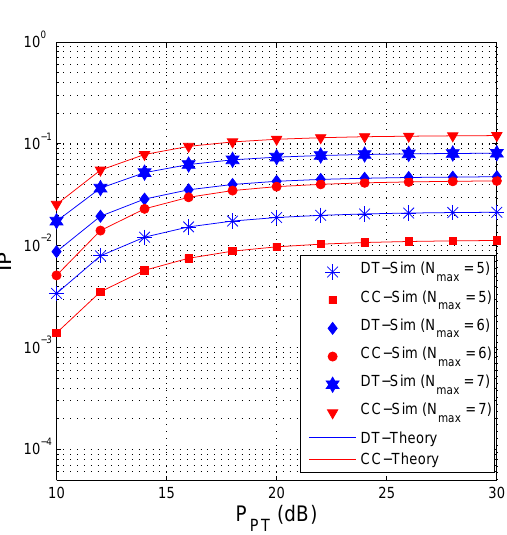
Figure 2. OP of the primary network as a function of P (dB).